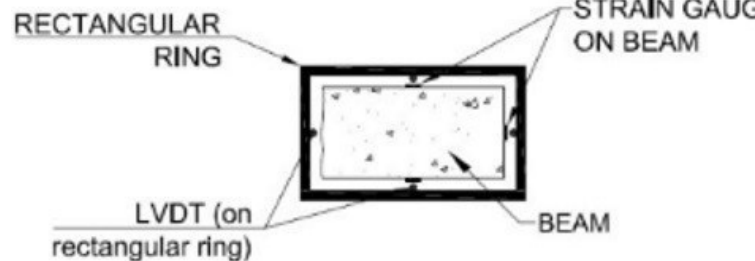
Figure 3. Set-up of direct tension test.